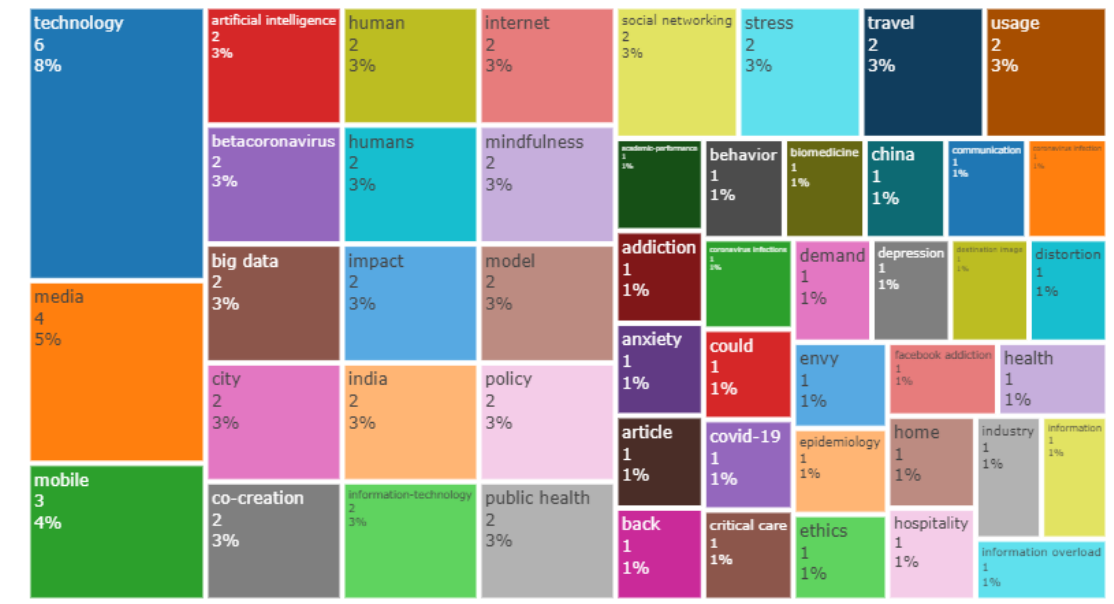
Figure 6. Main topics